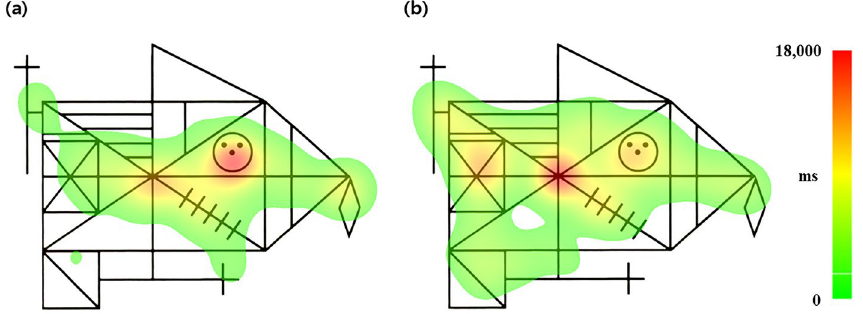
Figure 2. Hit maps showing cumulative eye gaze during the 3 min of memorizing the Rey-Osterrieth Complex Figure Test (RCFT) figure. ( a ) The distribution of eye gaze within the RCFT figure was narrow in a patient with the lowest organization T score (i.e., 33). ( b ) The distribution of eye gaze within the RCFT figure was wide in a patient with the highest organization T score (i.e., 70). The colored bar with numbers indicates the dwelling time of eye gaze